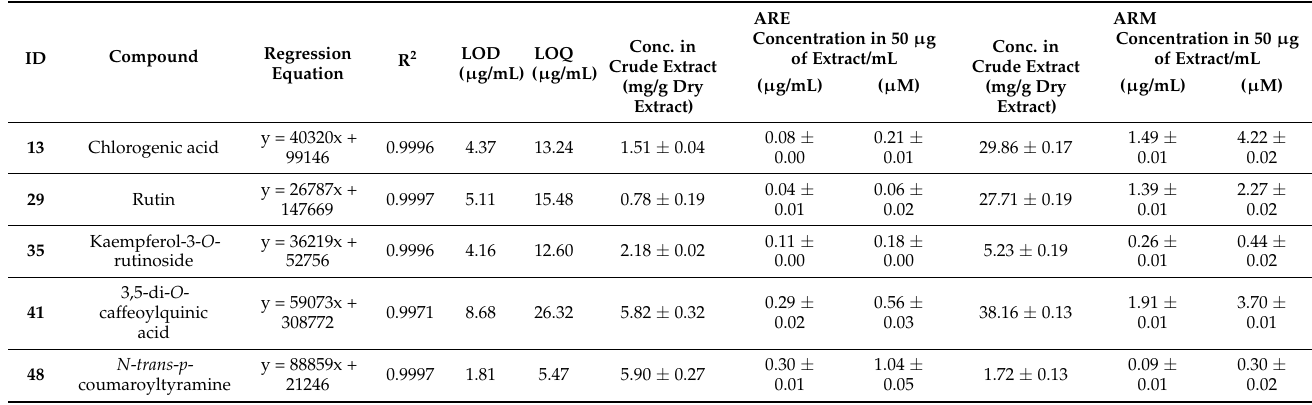
Table 2. Major phenolic compounds quantified in ARE and ARM.